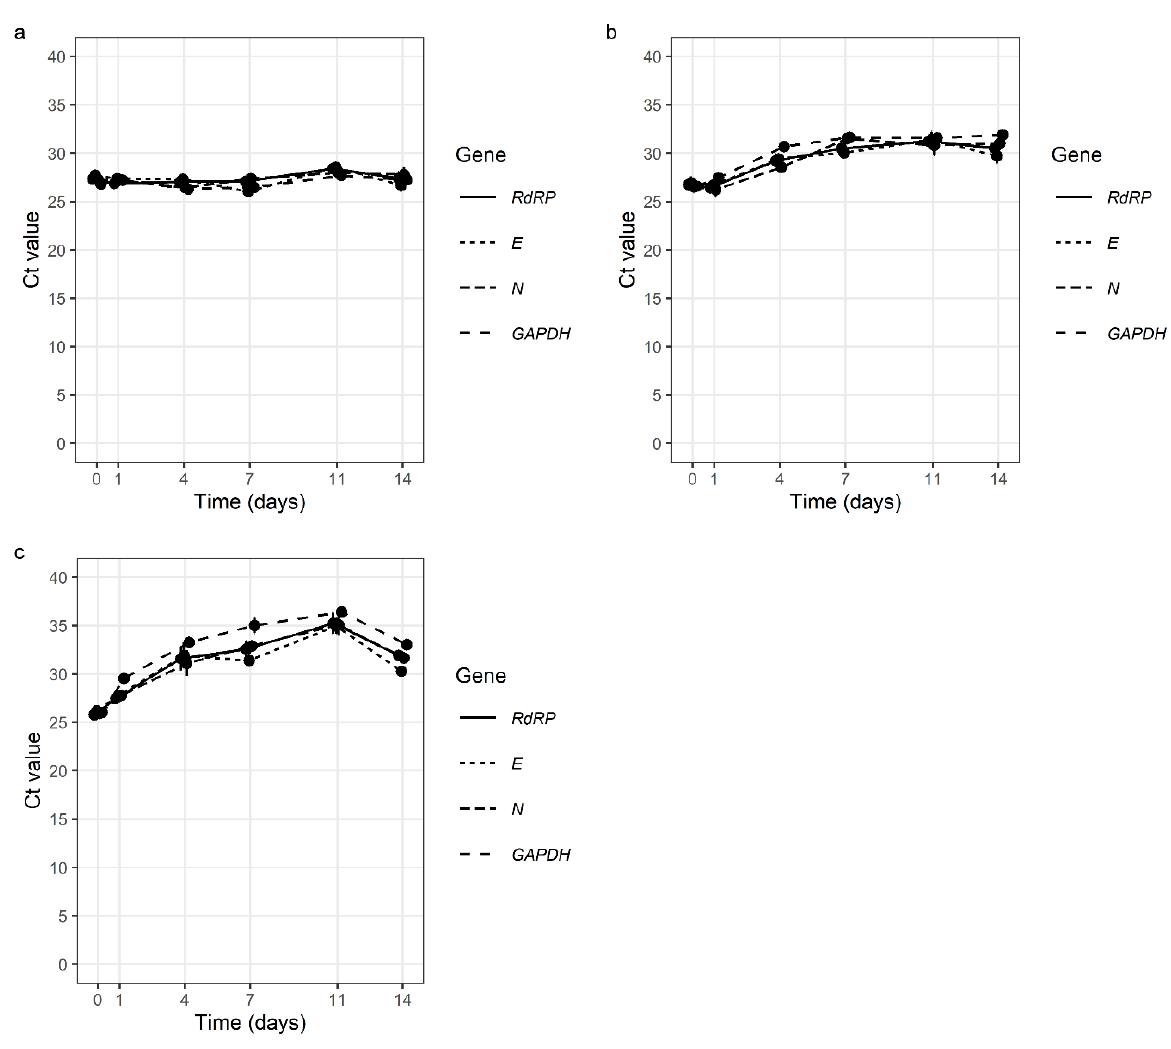
Figure 2. Stability of SARS-CoV-2 in simulated gargle lavage samples at 4 °C ( a ), at room temperature (24 °C – 27 °C) ( b ), and at 37 °C ( c ) over 14 days ( E gene — E gene of SARS-CoV-2; N gene — N gene of SARS-CoV-2 RdRP —gene for RNA-dependent RNA polymerase of SARS-CoV-2; GAPDH —gene for human glyceraldehyde-3-phosphate dehydrogenase (internal